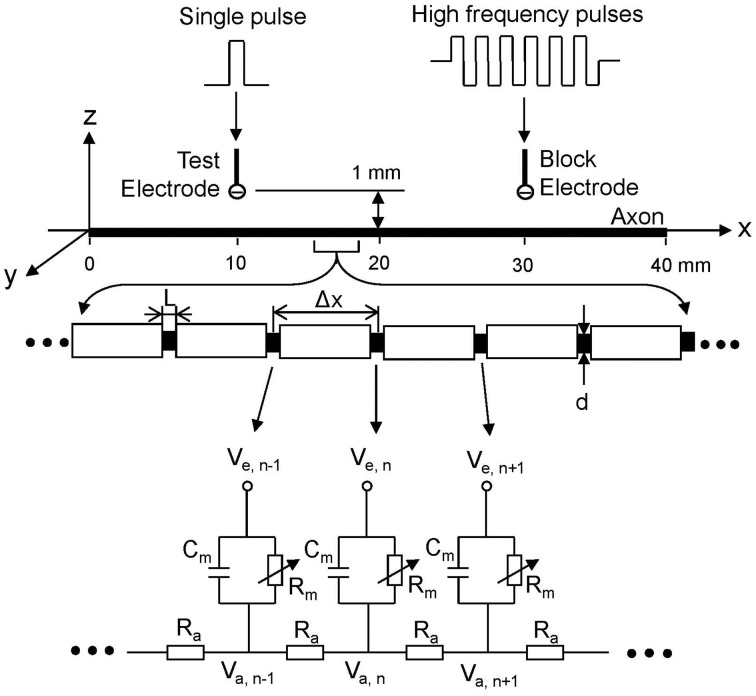
Myelinated axonal model used to simulate conduction block induced by high-frequency biphasic electrical current. The inter-node length Δx = 100 d; d is the axon diameter. L is the nodal length. Each node is modeled by a resistance-capacitance circuit based on the FH model. Ra, inter-nodal axoplasmic resistance; Rm, nodal membrane resistance; Cm, nodal membrane capacitance; Va,n, intracellular potential at the nth node; Ve,n, extracellular potential at the nth node.